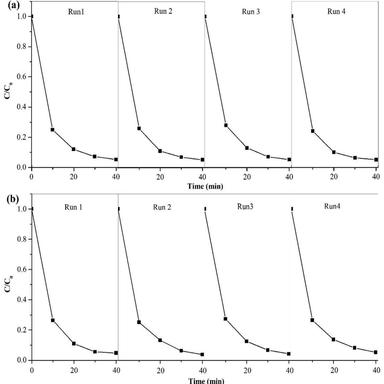
The photocatalytic degradation of MO (a) and MB (b) during four consecutive runs over STA-12(Fe)/sunlight/H2O2 system.